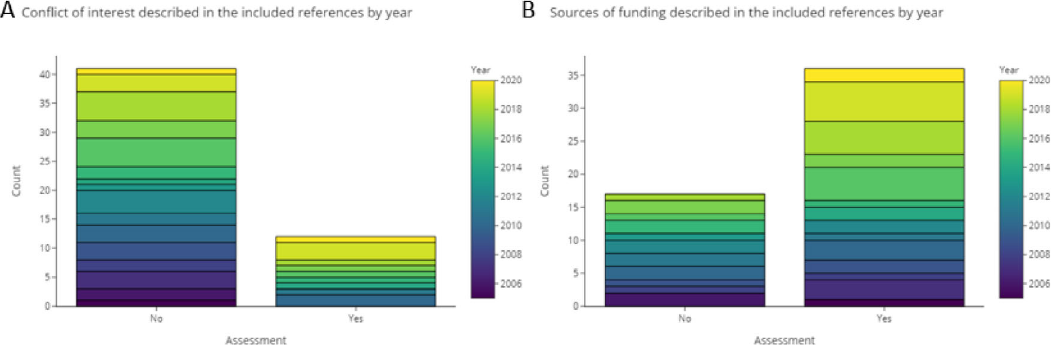
Figure 12. Declaration of funding sources and conflict of interest in the included